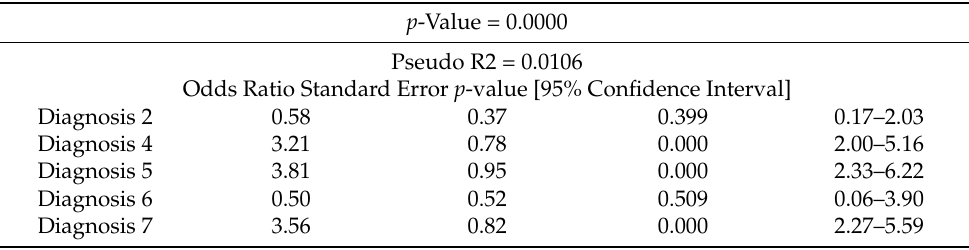
Table 3. Results of factorial logistic regression analysis testing the relationship between diagnosis and period. p -Value =